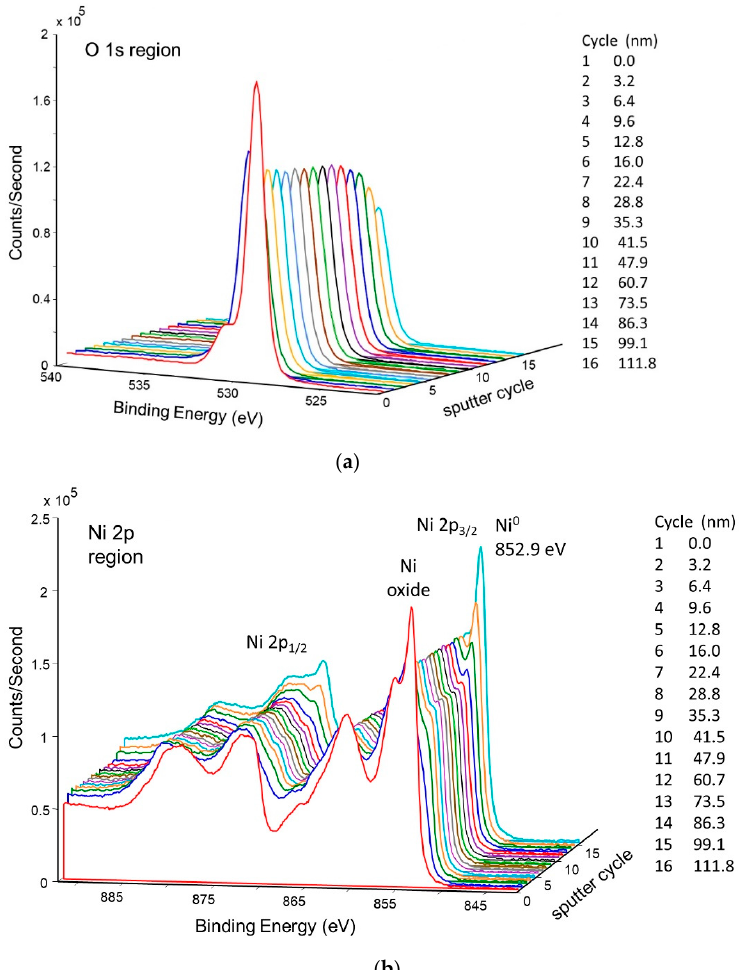
Figure 9. Depth profile of pretreated NPG surface b-sample showing ( a ) corresponding decrease in oxygen, ( b ) change from NiO to Ni .